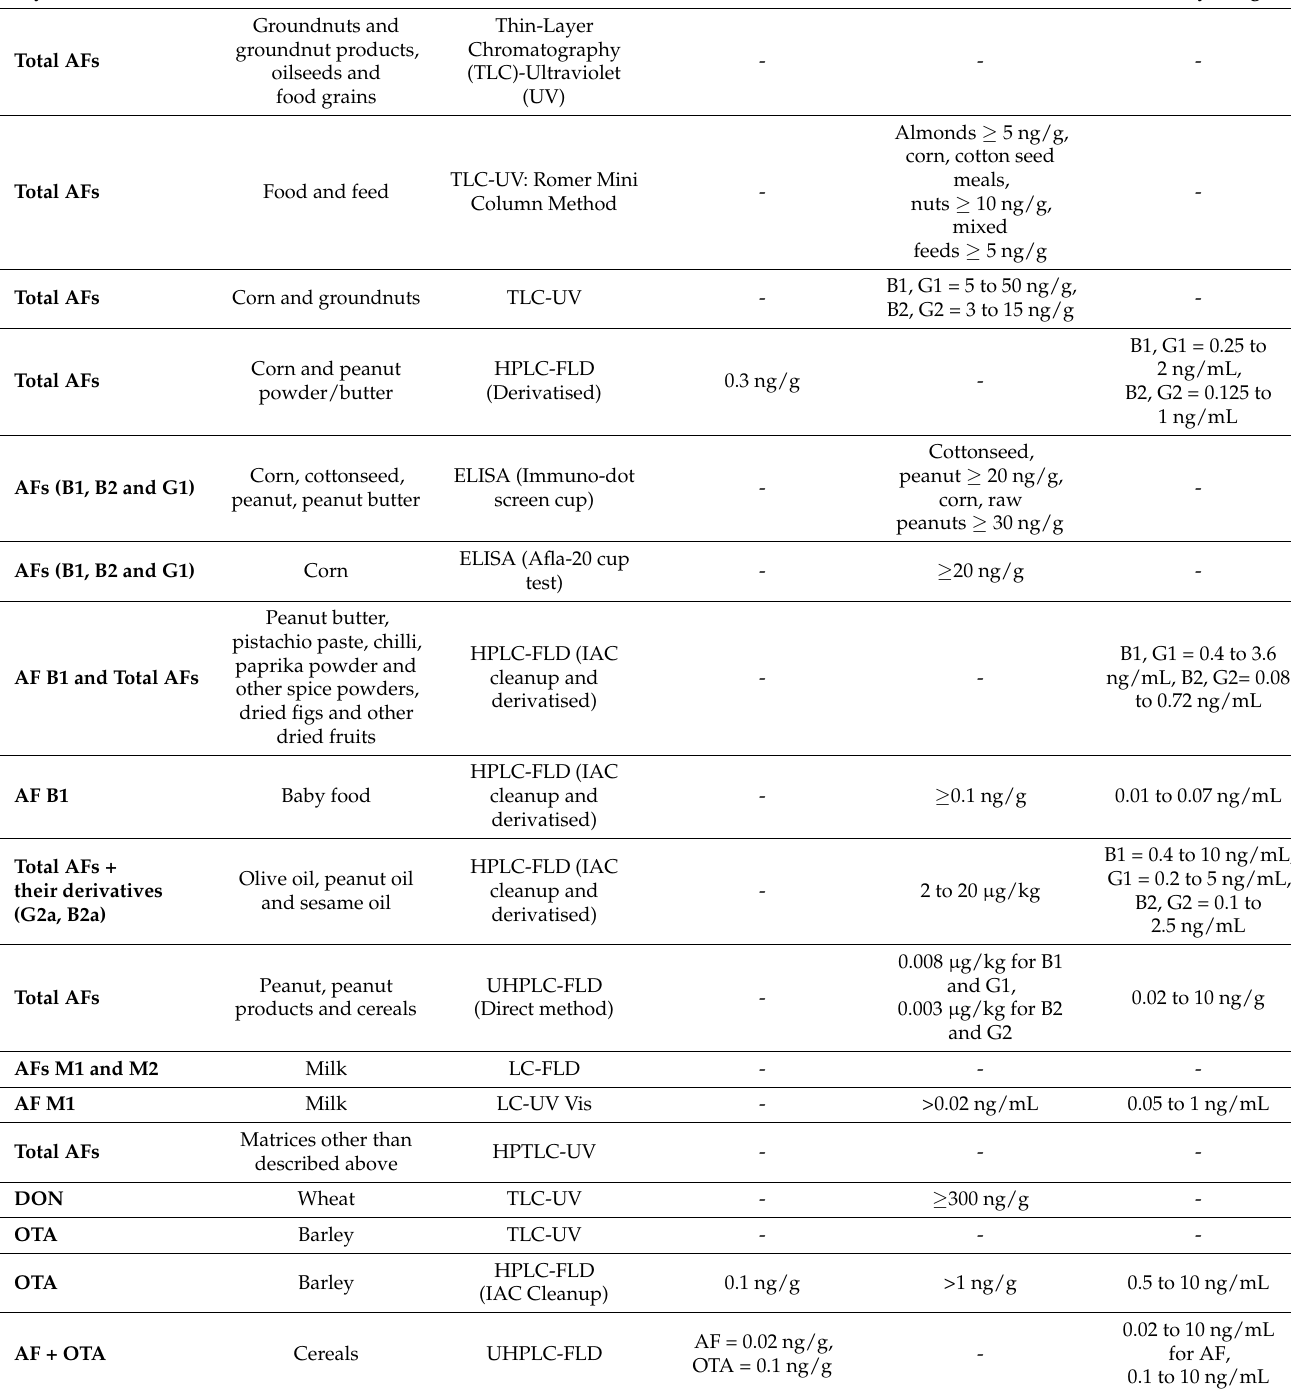
Table 2. Summary of currently practised mycotoxin detection methodologies as per FSSAI Manual of Methods of Analysis of